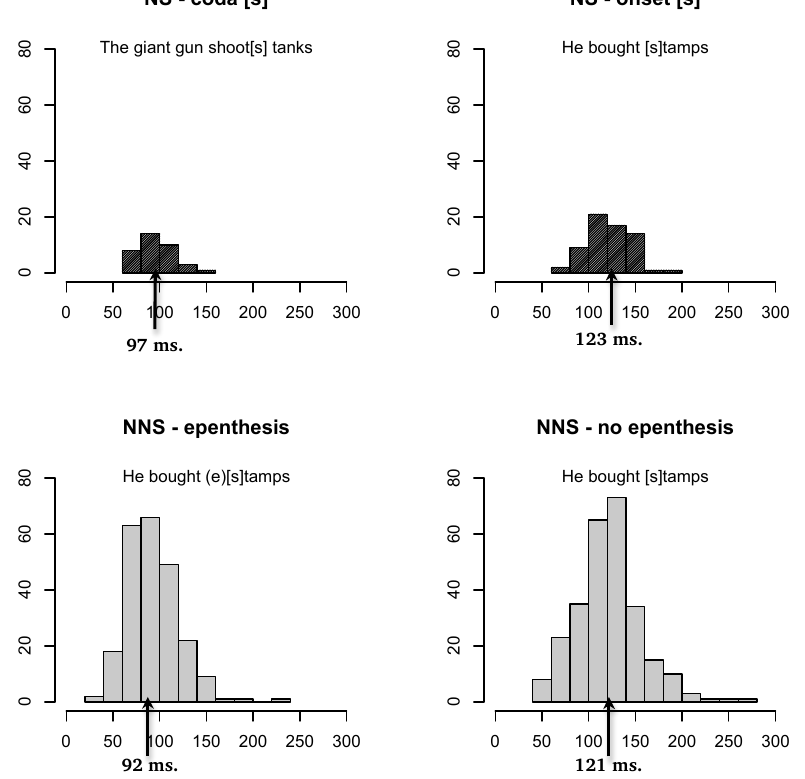
Figure 5 . Histogram of native speaker’s [s] duration distributions in coda and onset position and nonnative speakers’ [s] duration distributions with and without